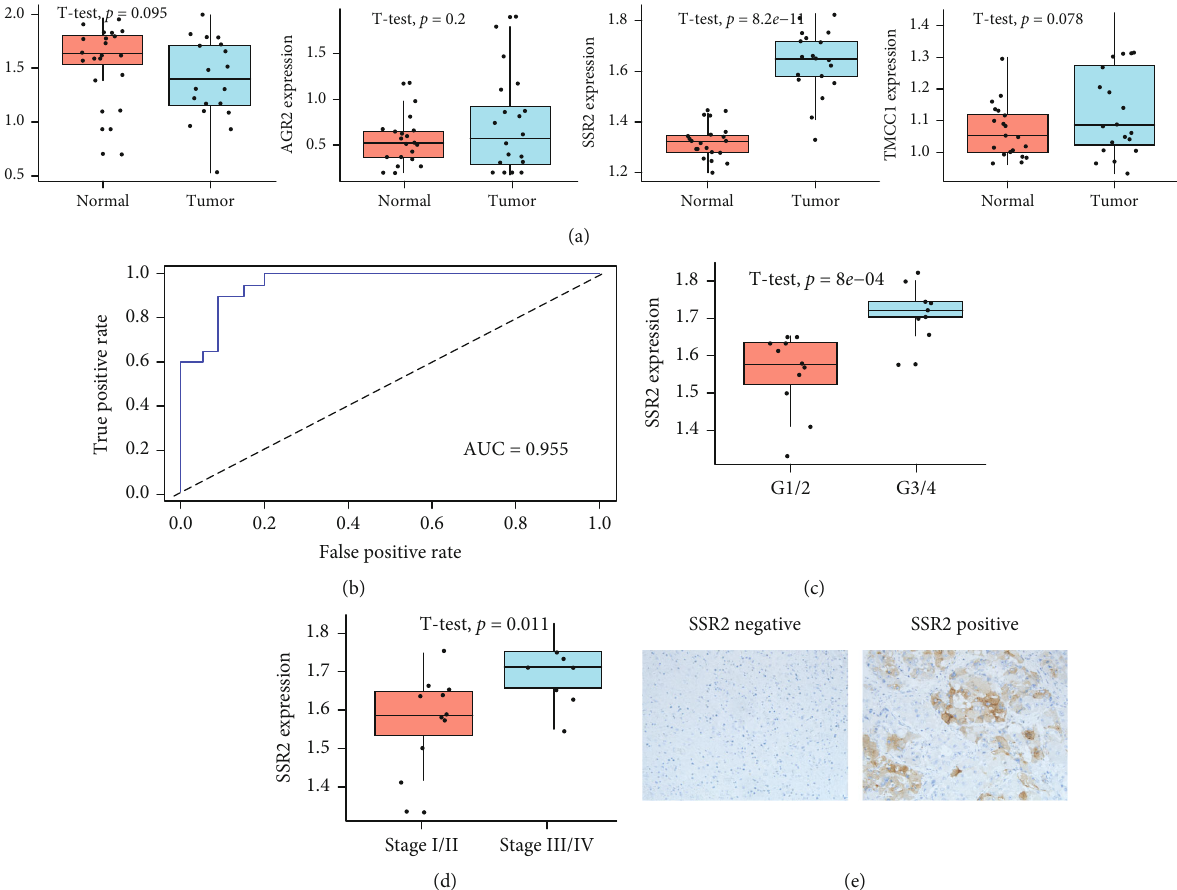
Figure 8: Validation of this feature in clinical samples. (a) Expression levels of mRNA molecules in our risk model. (b) ROC curve. (c, d) SSR2 was associated with poor progression. (e) The protein expression of SSR2 was overexpressed in HCC compared to normal